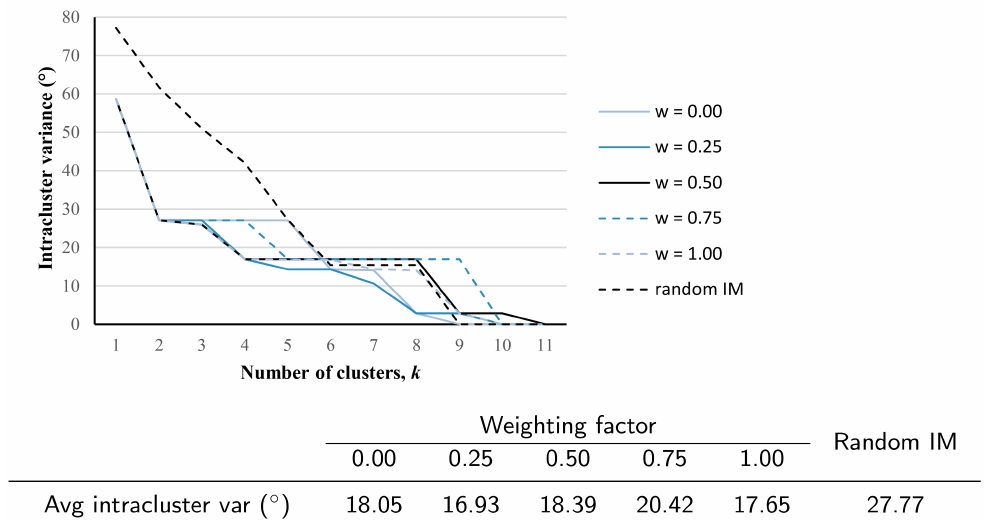
Figure 6. Comparison of the novel initialisation method to the random initialisation of the k -means algorithm. The average intracluster variance of the generated clusters for the different weighting factors shows that the novel method outperforms the random initialisation of k